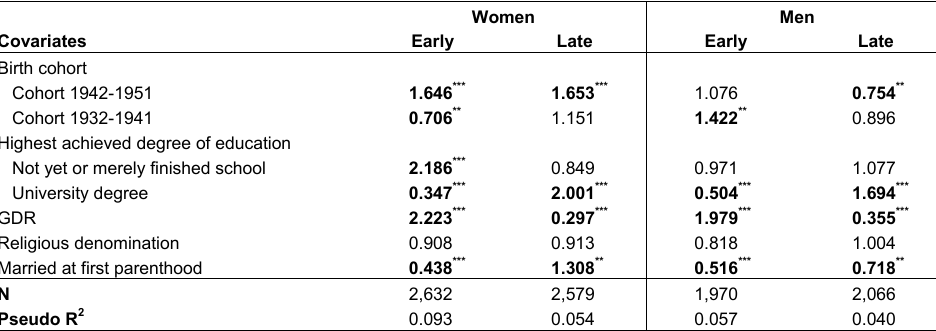
Odd ratios from logit model predicting timing of first parenthood status, by sex and birth